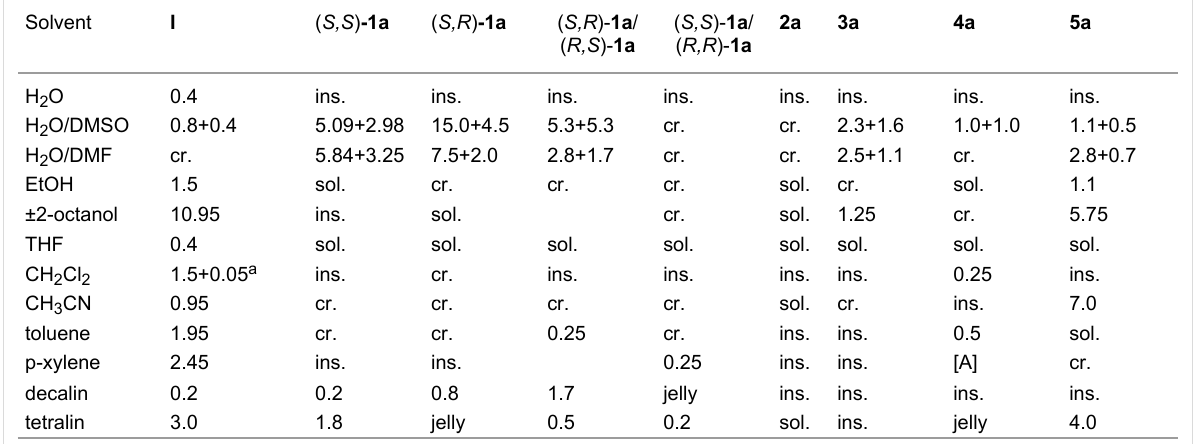
Table 1: Gelator effectivenesses (G eff , mL) of retro-dipeptides 1a – 5a and bis(Leu)oxalamide I in gelation of various solvents and solvent mixtures (sol.: soluble; ins.: insoluble; cr.: crystallization; [A] gel/sol mixture). Solvent